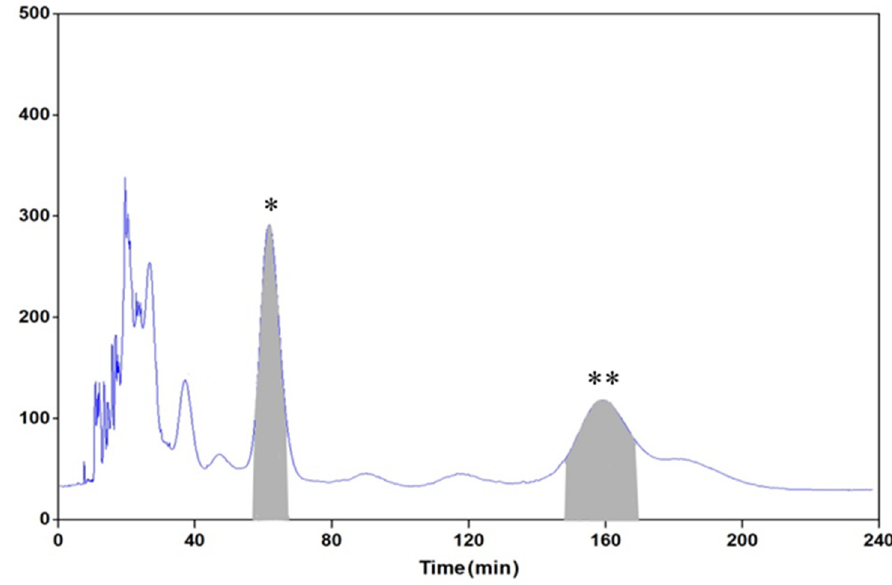
Figure 5. High-speed counter-current chromatography (HSCCC) chromatogram of the Fr. III. Experimental conditions: Two-phase solvent system: n -hexane-ethyl acetate-water containing 1% acetic acid (1:4:8, v/v/v); stationary phase: Upper phase; mobile phase: Lower phase; elution mode: Head to tail; flow rate: 3.0 mL/min; rotation speed: 900 rpm; separation temperature: 25 °C; detection wavelength: 254 nm; sample loading: 80 mg of the Fr. III dissolved in 5 mL of the lower phase; retention of the stationary phase: 71%. Peaks: *, isochlorogenic acid B; **, isochlorogenic acid A.